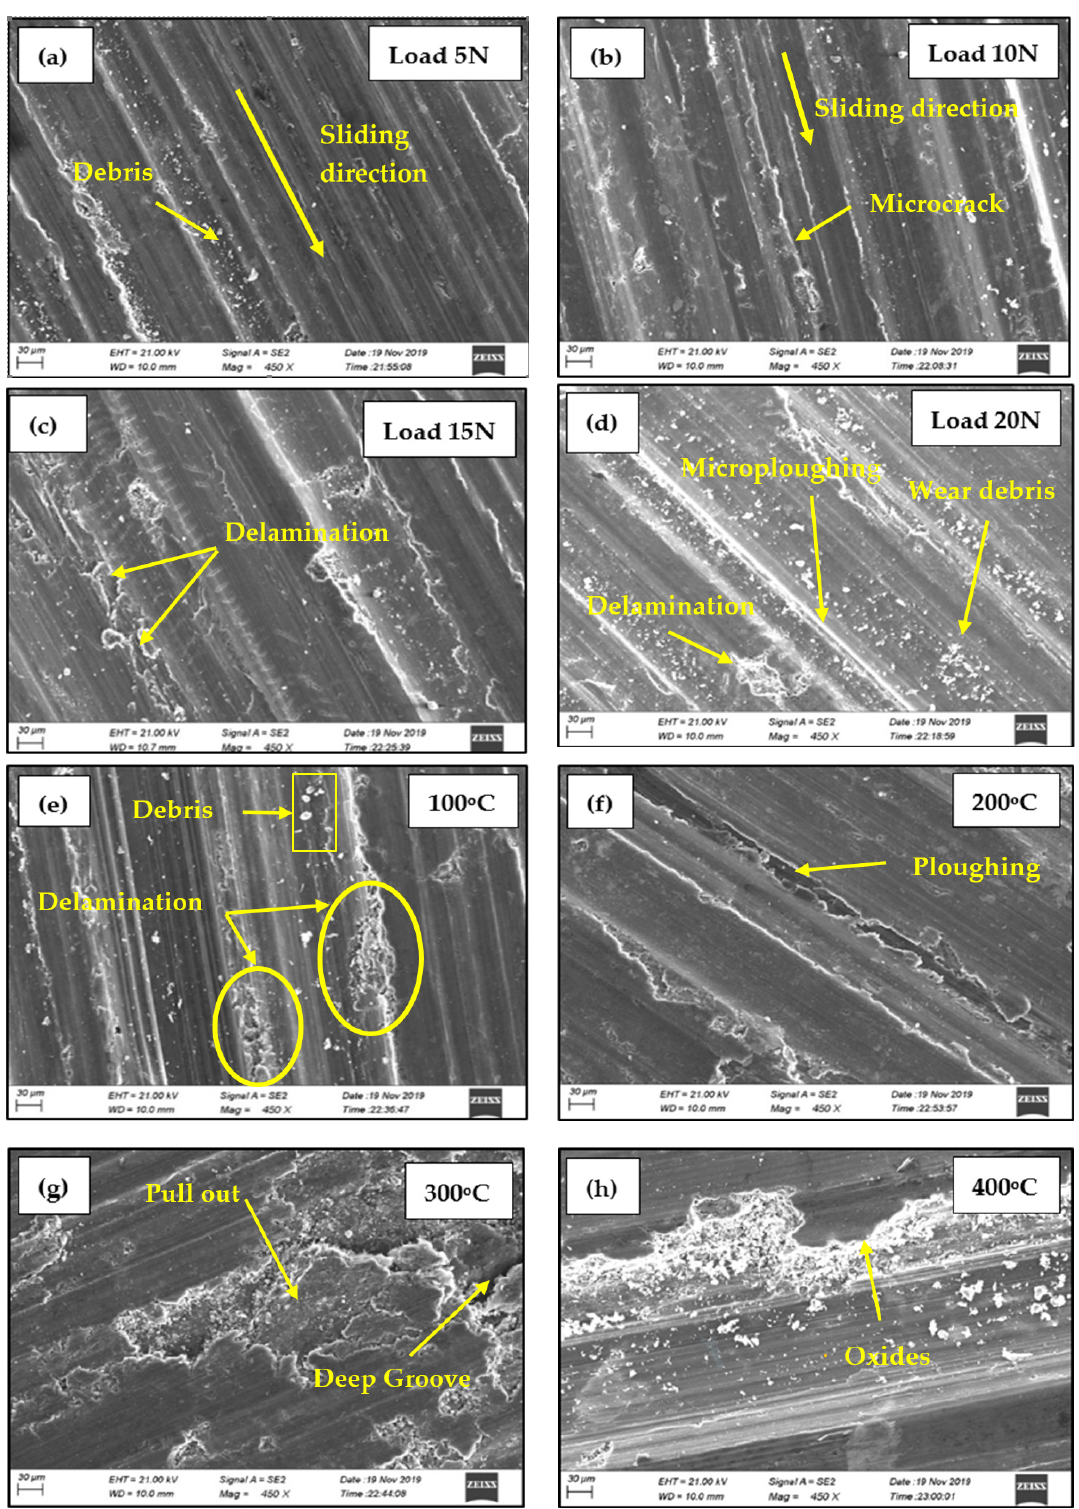
Figure 14. SEM images of worn samples of Al-CNT-Sn composite with 1.0 wt. % CNT: ( a ) dry sliding wear with 5 N load at room temperature (RT); ( b ) dry sliding wear with 10 N load at RT; ( c ) dry sliding wear with 15 N load at RT; ( d ) dry sliding wear with 20 N load at RT; ( e ) wear at 100 ◦ C with 20 N load; ( f ) wear at 200 ◦ C with 20 N load; ( g ) wear at 300 ◦ C with 20 N load; ( h ) wear at 400 ◦ C with 20 N